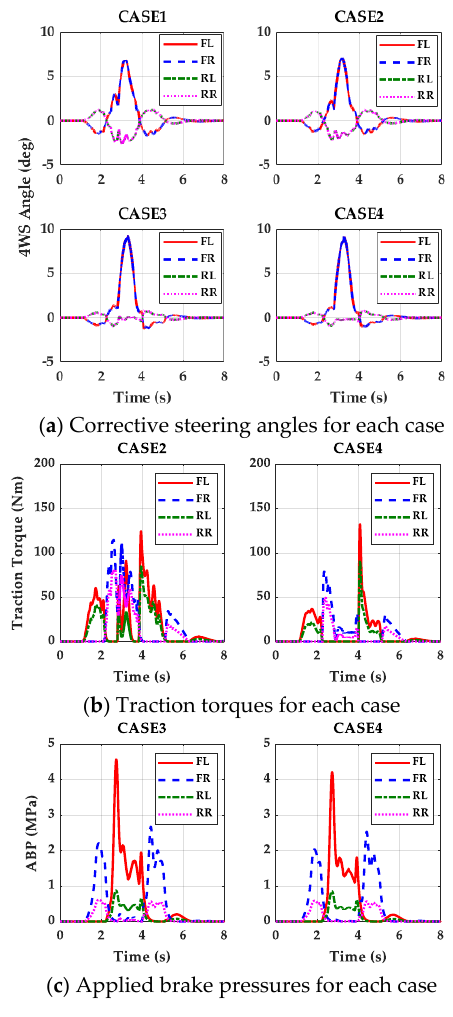
Figure 8. Control inputs for each case. Energies 2021 , 14 , 6306